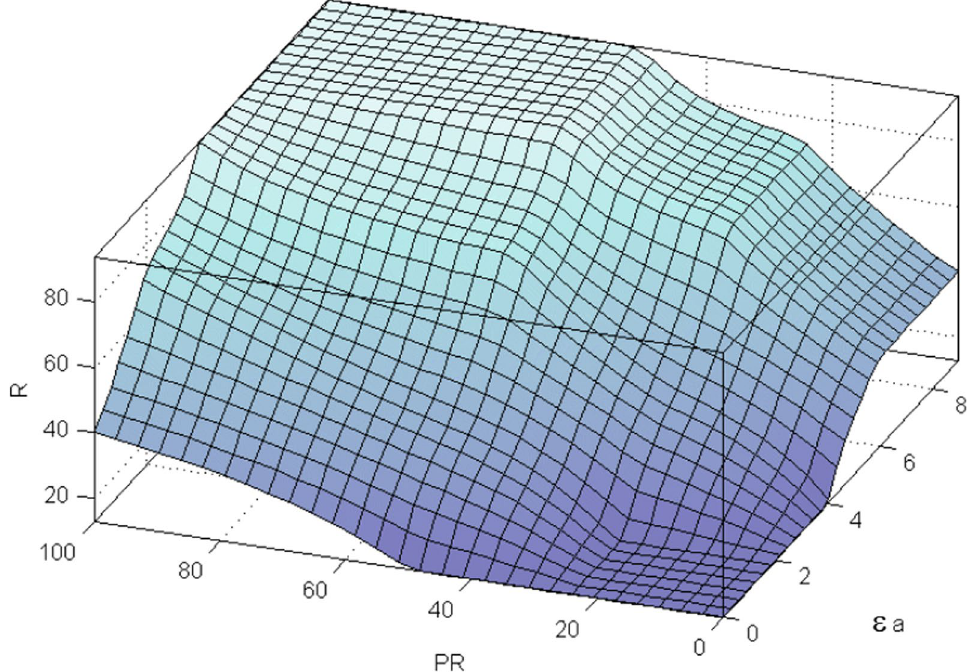
Fig. 6 Risk surface (R) of a gas pipeline depending on its strength and axial horizontal